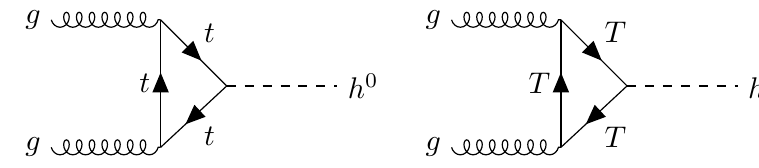
Figure 2. SM Higgs production dominant diagrams at the